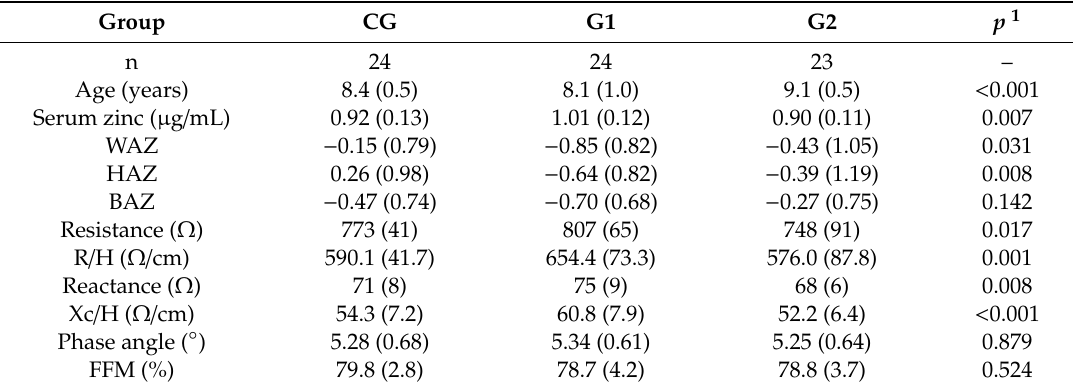
Table 1. Group characterization before oral zinc supplementation with di ff erent concentrations